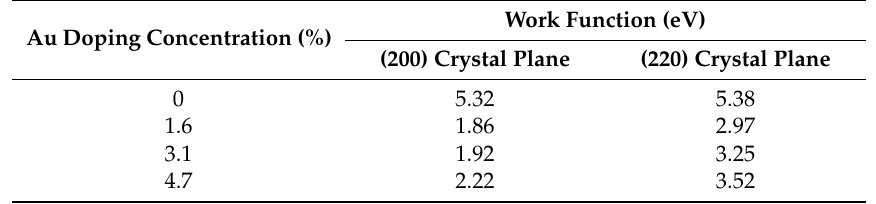
Table 1. Work functions of the (200) and (220) crystal planes of an undoped MgO crystal and three Au-doped MgO crystals with doping concentrations of 1.6%, 3.1%, and 4.7%. Work Function (eV) Au Doping Concentration (%) (200) Crystal Plane (220) Crystal